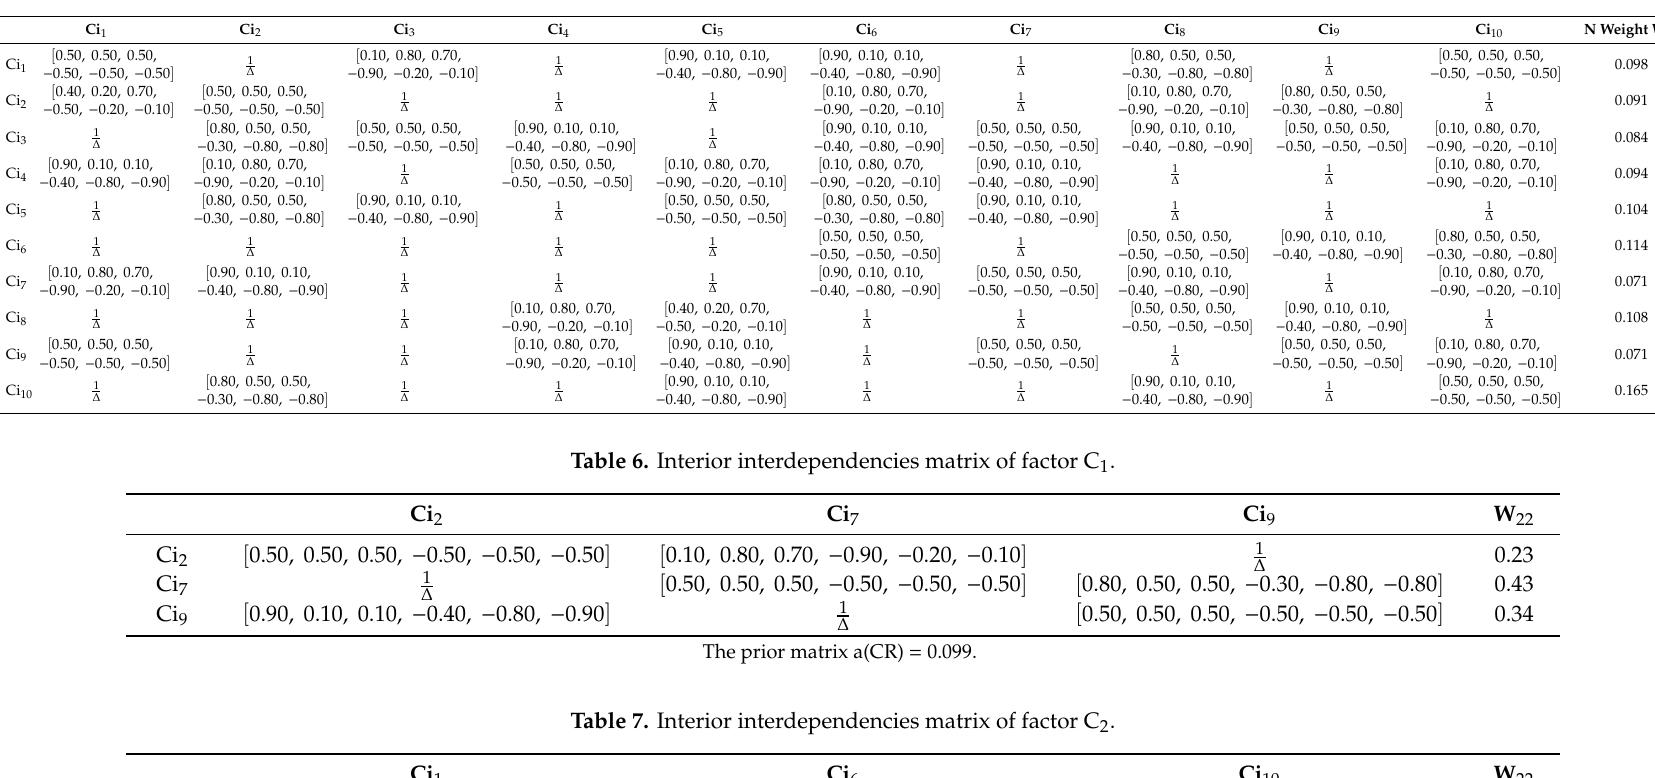
Table 5. Pairwise discrimination for W 21 .